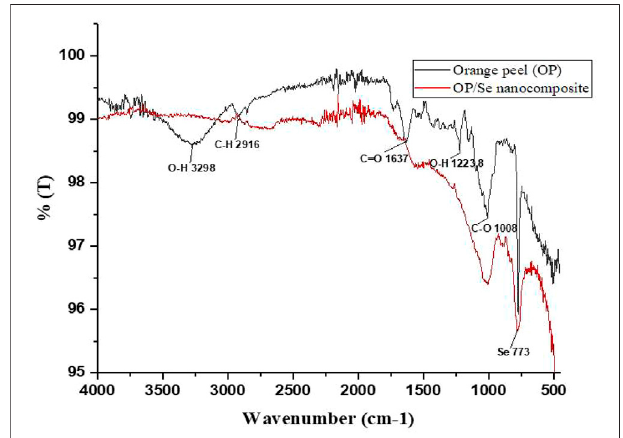
FIGURE 2 | FT-IR spectra of orange peel and orange peel/selenium